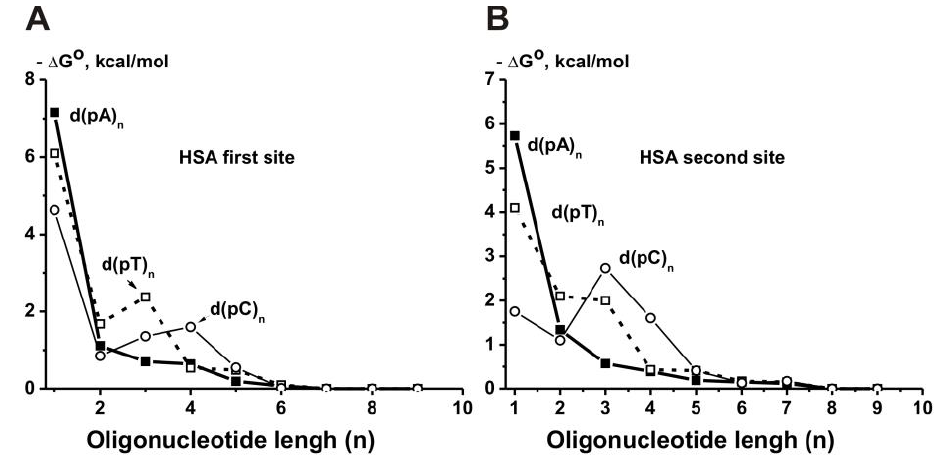
Figure 18. Thermodynamic values ( − ∆ G ◦ ) characterizing a relative contribution of various mononucleotides of ss ODNs to the total affinity of these d(pN) 8 for the first ( A ) and the second ( B ) sites of human serum albumin (has). Different ss d(pN) n are shown on panels ( A , B ) [125]. The second strand’s contribution to the affinity of ds DNA for all analyzed enzymes is usually much smaller than that for the first one. HSA demonstrated a significantly lower affinity for complementary ds d(pN) n>10 with T m melting points higher than the temperature used (Figure 16B,C; Supplementary Tables S22 and S23). However, in general, DNA recognition by albumin occurs in accordance with the same regularities as for other enzymes and proteins